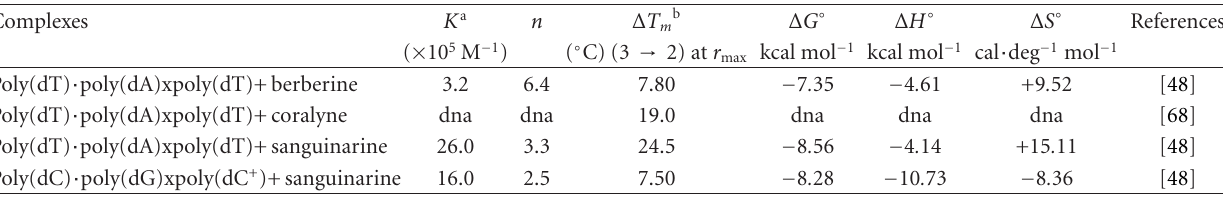
a K (the intrinsic binding constant) determined using equation r/C bound per mole of nucleotide and C f is the molar concentration of free alkaloid. b Δ T m (3 → 2) is the T m of the triplex DNA in the presence of alkaloid- T m of the free triplex DNA. (3 → 2) denotes the transition temperature from triplex complex to duplex complex formation. ∗ dna: data not available.